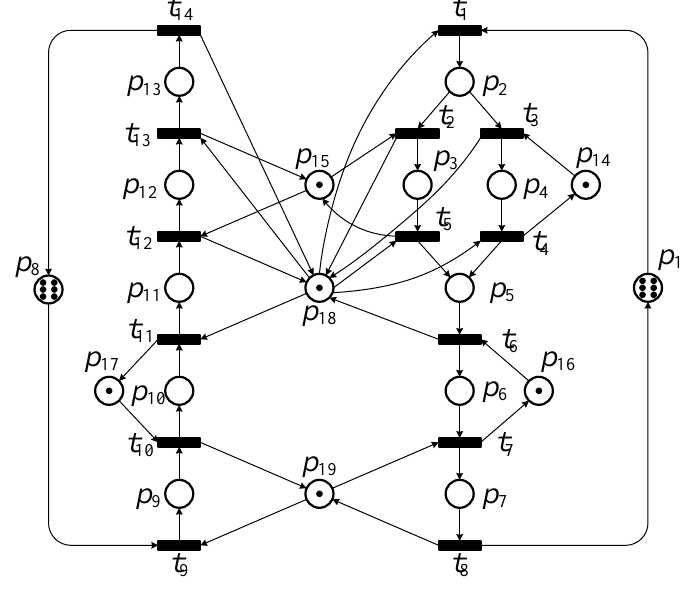
Figure 6. Another classical and complex Petri net model of FMS. Table 5. The detailed information of all legal markings of Example 2.